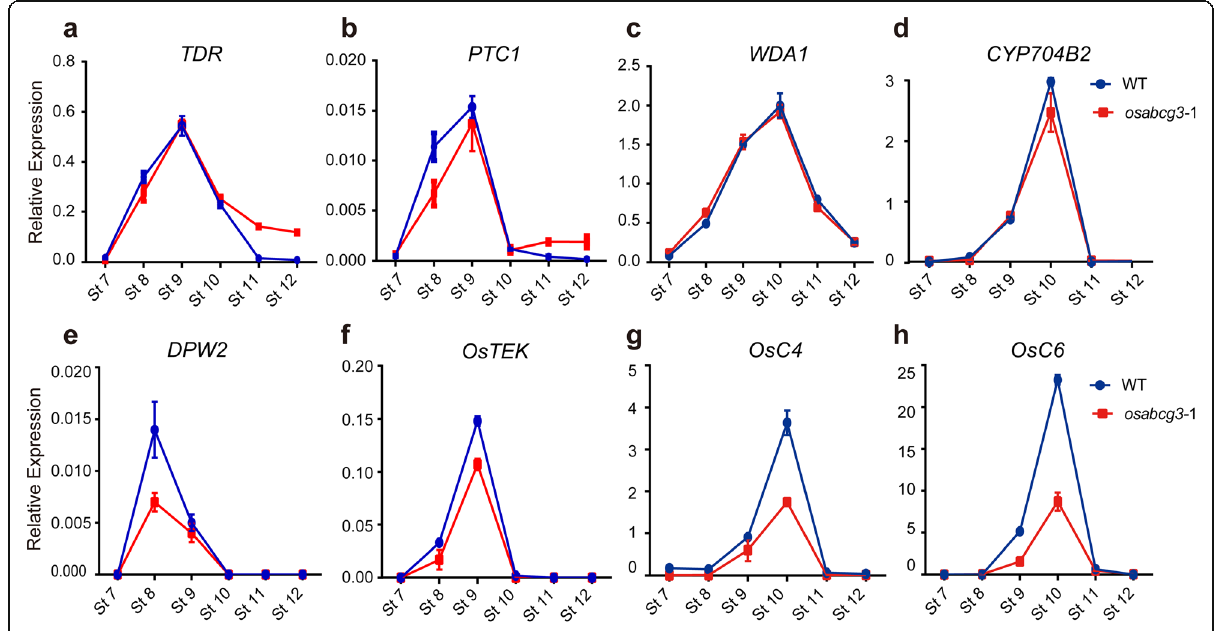
Fig. 6 Expression of genes related to pollen development in the WT and osabcg3 – 1 anthers. Expression of TDR (a) , PTC1 (b) , WDA1 (c) , CYP704B2 (d) , DPW2 ( e ), OsTEK ( f ), OsC4 (g) and OsC6 (h) at stage 7 to 12 in the WT and osabcg3 – 1 was analyzed using qRT-PCR. OsACTIN1 served as an internal control. Data are shown as means ± SD ( n = 3)